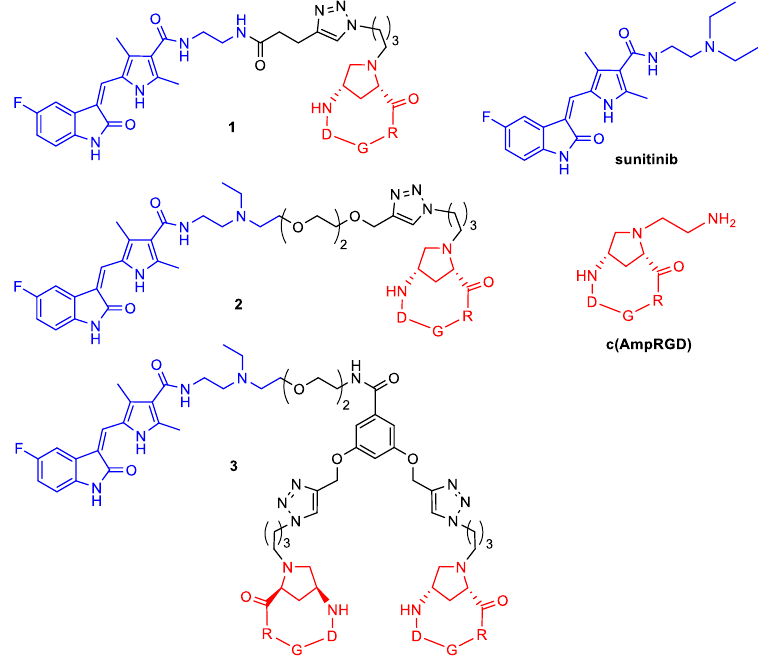
Figure 1. Molecular structures of conjugates 1 – 3 and the parent sunitinib and c(AmpRGD) components.